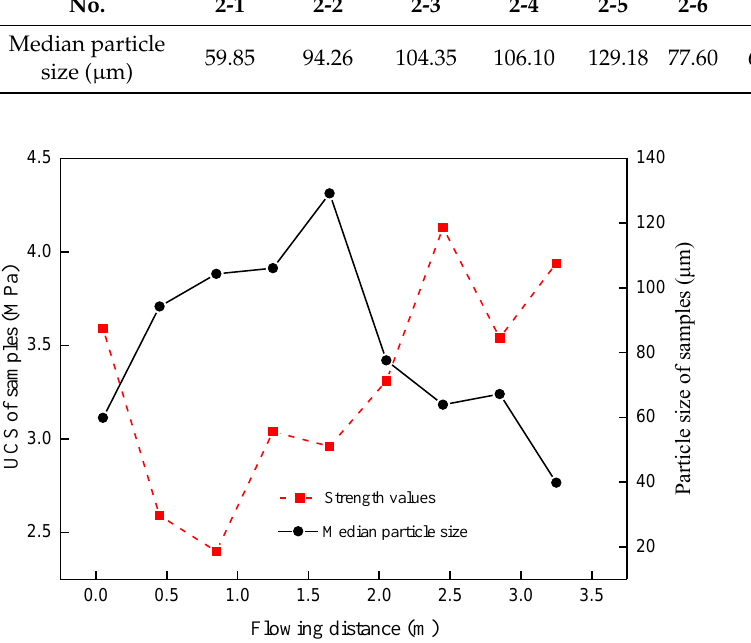
Figure 9. Comparison chart of the median particle sizes and UCS of samples in row 2 along the flowing direction.